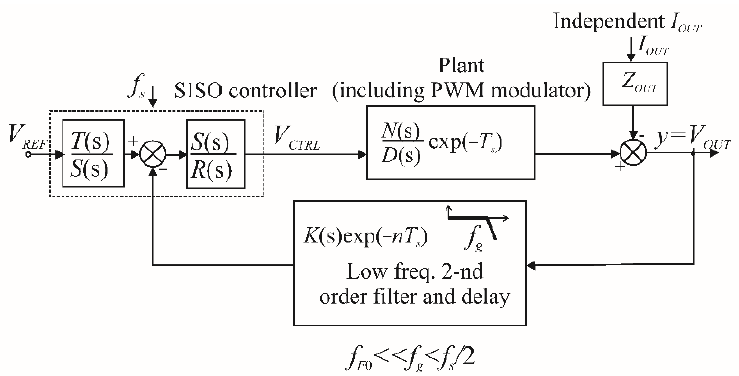
Figure 2. SISO control of a VSI.